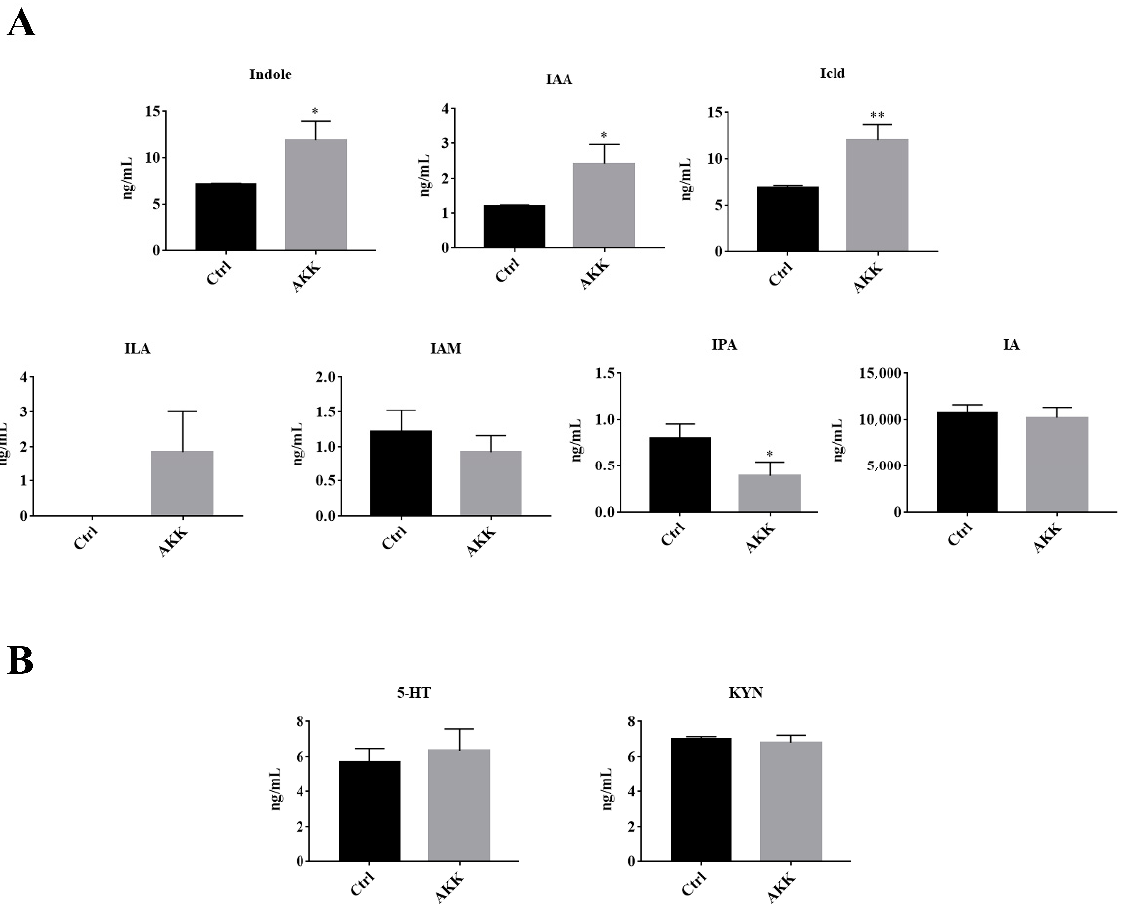
Figure 4. The concentrations of tryptophan metabolites in supernatant of A. muciniphila BAA-835 T . * p < 0.05, ** p < ( A ) Indole and its derivatives. ( B ) 5-HT and KYN. Student’s t -test was used to determine statistical differences, compared with the Ctrl group. * p < 0.05, ** p < 0.01.